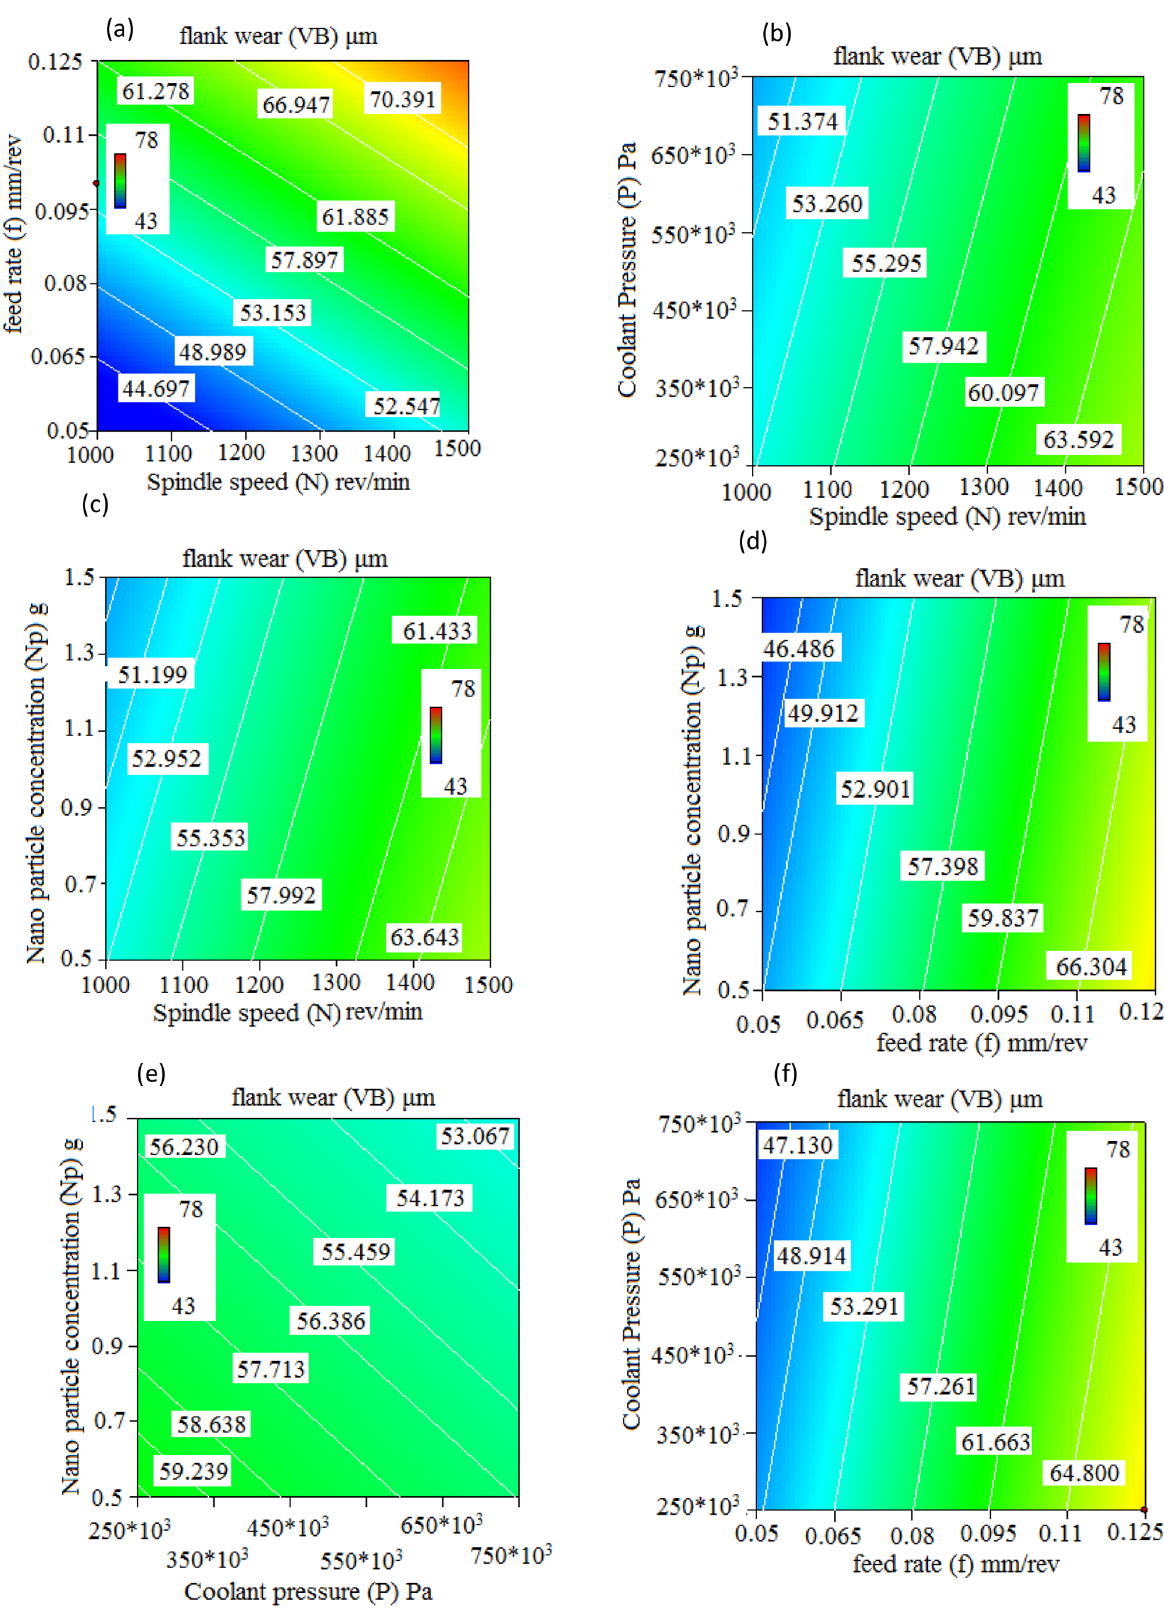
Fig. 12. (a-f) Effect of process parameters on ‘ VB ’ , (a) Effect of ‘ N ’ at varying ‘ f ’ on ‘ VB ’ . (b) Effect of ‘ N ’ at varying ‘ P ’ on ‘ VB ’ , (c) Effect of ‘ N ’ at varying ‘ Np ’ on ‘ VB ’ (d) Effect of ‘ f ’ at varying ‘ Np ’ on ‘ VB ’ (e) Effect of ‘ P ’ at varying ‘ Np ’ on ‘ VB ’ , (f) Effect of ‘ f ’ at varying ‘ P ’ on ‘ VB ’